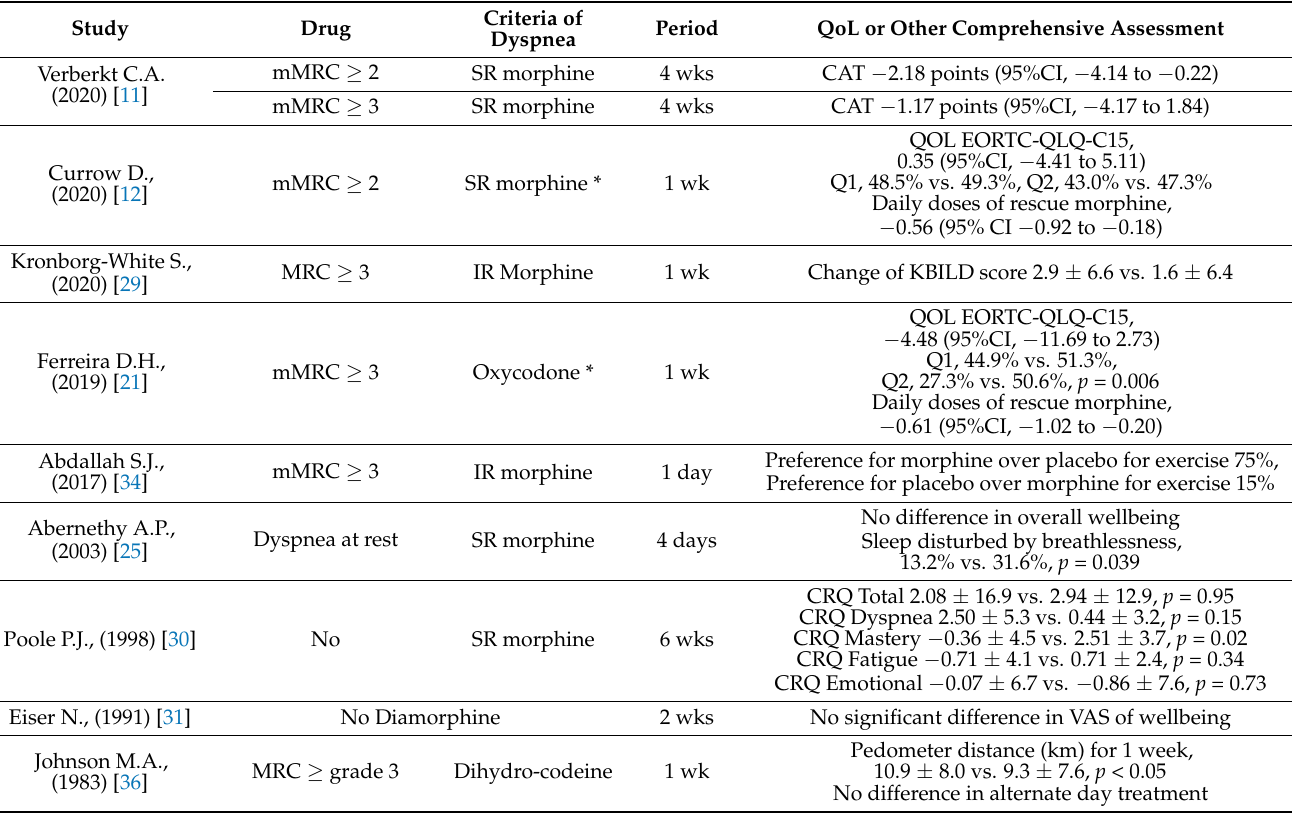
Table 7. Quality of life (QoL) or other comprehensive assessments in randomized controlled